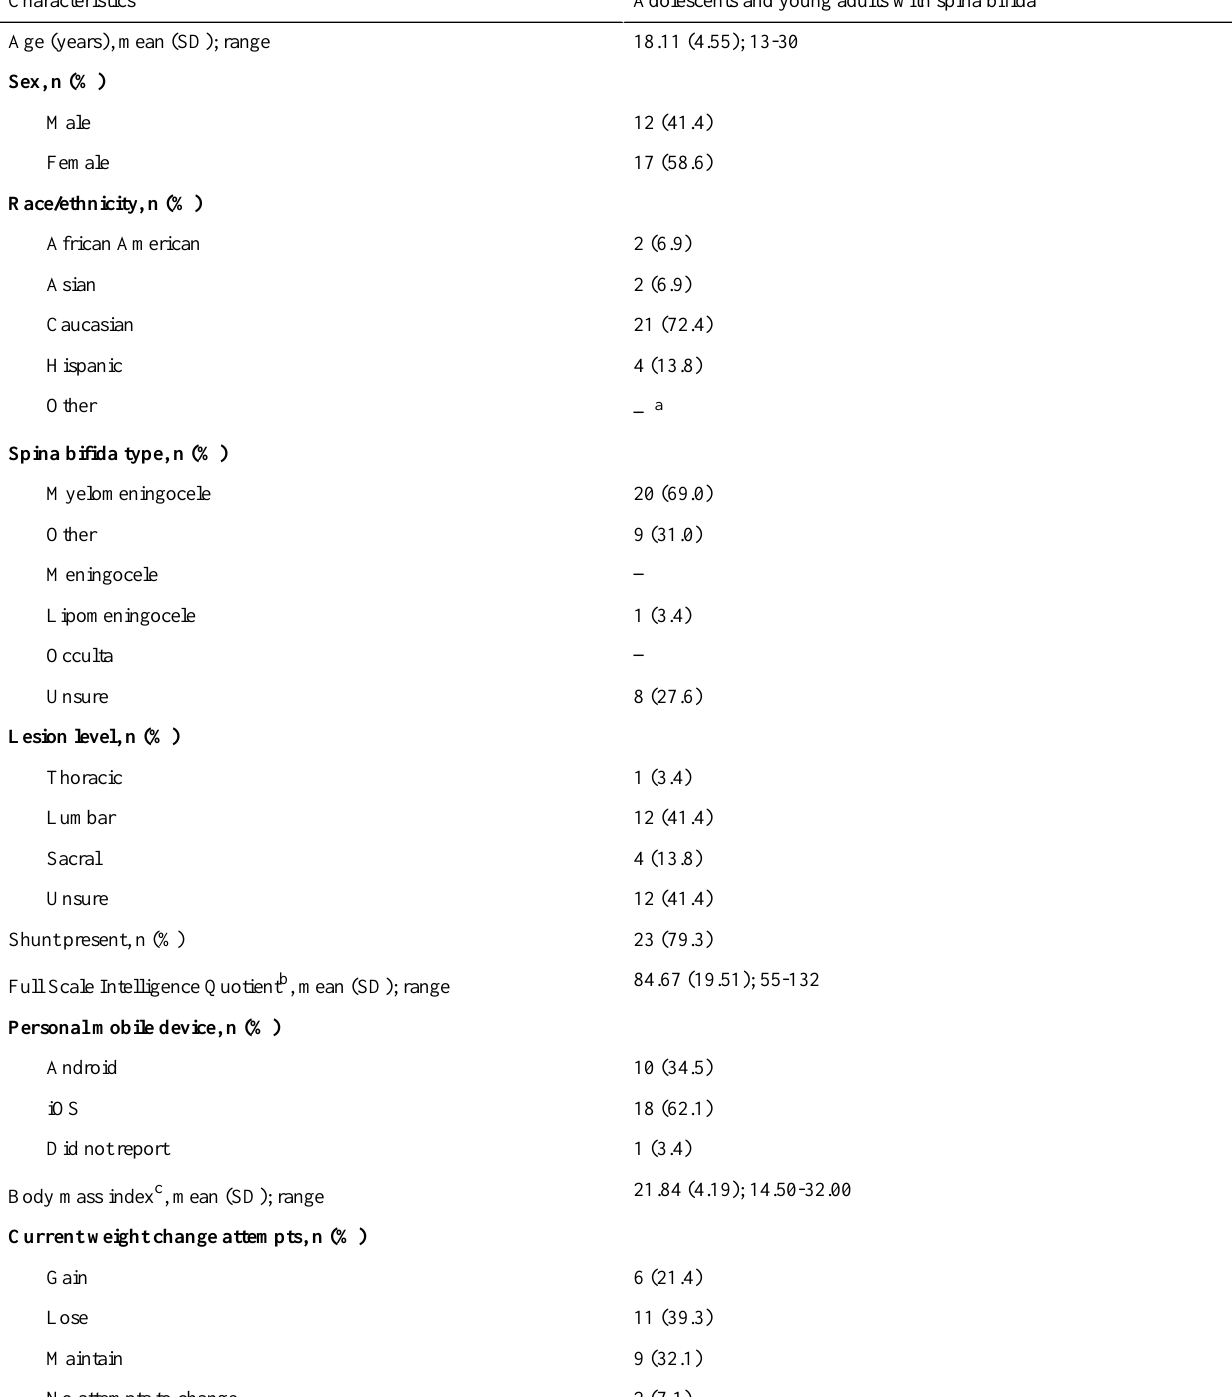
Adolescents and young adults with spina